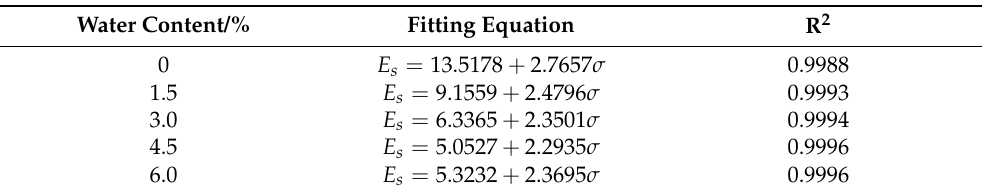
Table 4. Fitting equations for the relationship between compression modulus and axial stress under different water content conditions.